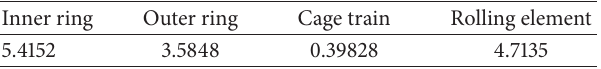
Table 2: The fault feature frequency about the 6205-2RS JEM SKF (multiple of running speed in